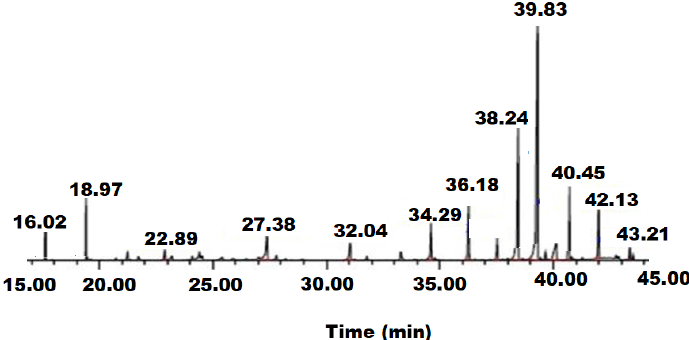
Figure 1. GC-MS chromatogram of nutmeg oil chemical components.